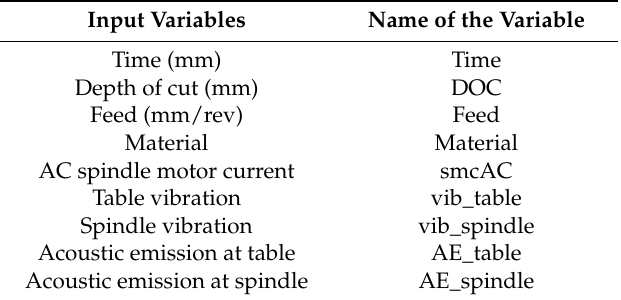
Table 3. Operation input variables used in this study and their names.